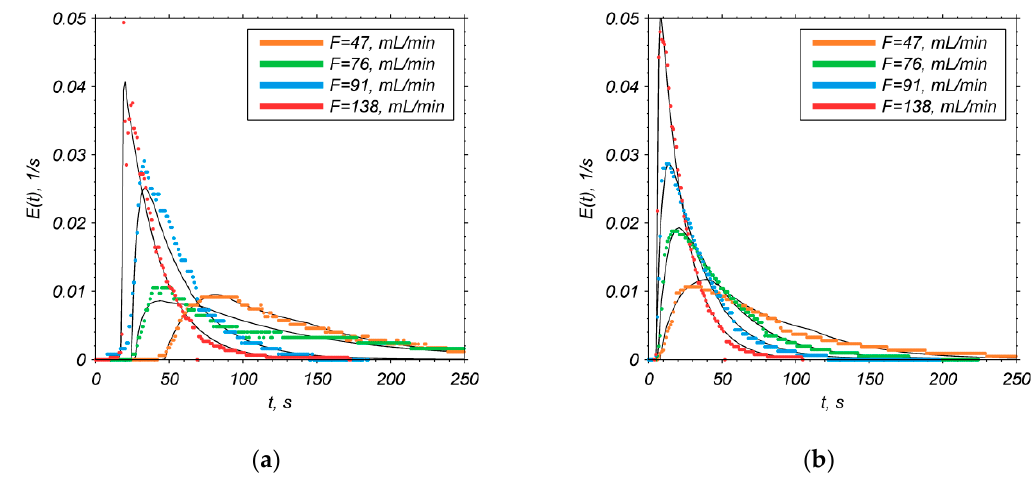
Figure 2. Exit time distributions in the reactor vessel, when the ultrasounds are: ( a ) switched off; ( b ) switched on. Black continuous lines are model responses.